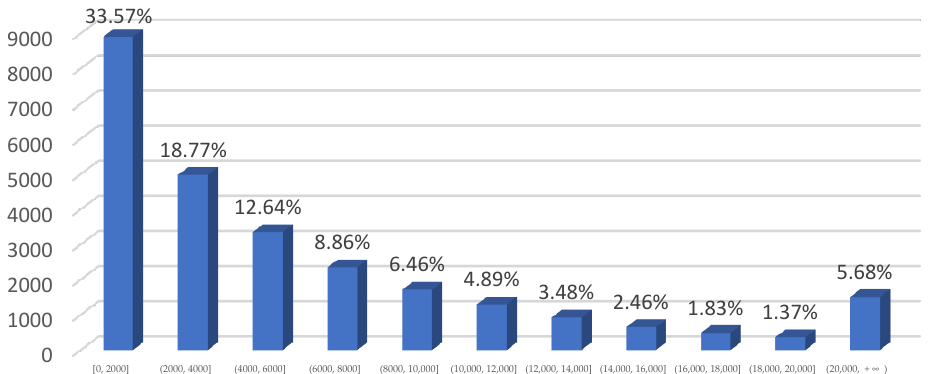
Figure 7. Proportion of text bounding boxes with different tilt angles. In this paper, the tilt angle of the text box is divided into 11 intervals with an interval of 10 degrees, ‘ + ’ represents the tilt of the text box to the left and ‘−’ represents the tilt to the right.